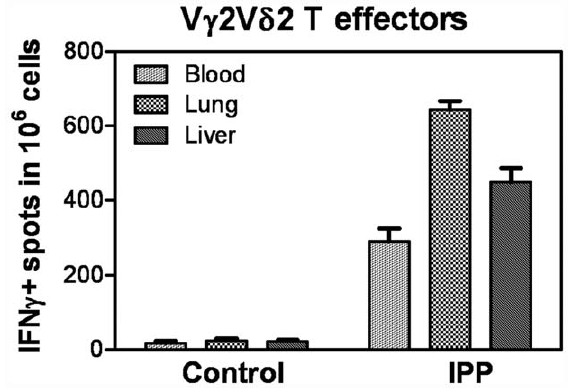
Figure 5. V c 2V d 2 T cells that accumulated in tissue compart- ments could mount effector function and produce anti-TB cytokine. Shown are ELISPOT data for IPP-driven IFN c + cellular response in lymphocytes from blood, lung and liver collected from four Mtb-infected macaques at 4–6 weeks after the infection. Data were subtracted from values of glucose/medium control and expressed here as IFN c + V c 2V d 2 T cells in 10 ‘ 6 lymphocytes. IPP stimulates activation of only V c 2V d 2 T cells but not other immune